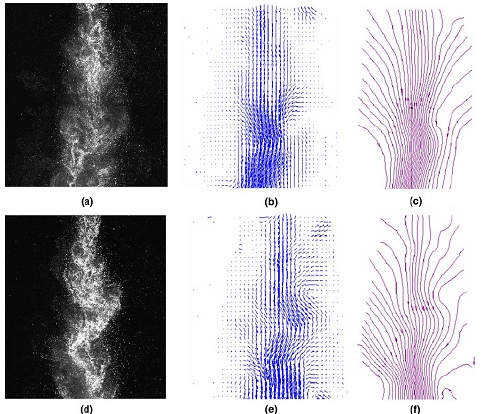
Figure 3. DMC and diesel sprays: ( a ) DMC spray particle image; ( b ) DMC spray velocity vector distribution; ( c ) DMC spray streamline distribution; ( d ) diesel spray particle image; ( e ) diesel spray velocity vector distribution; and ( f ) diesel spray streamline distribution